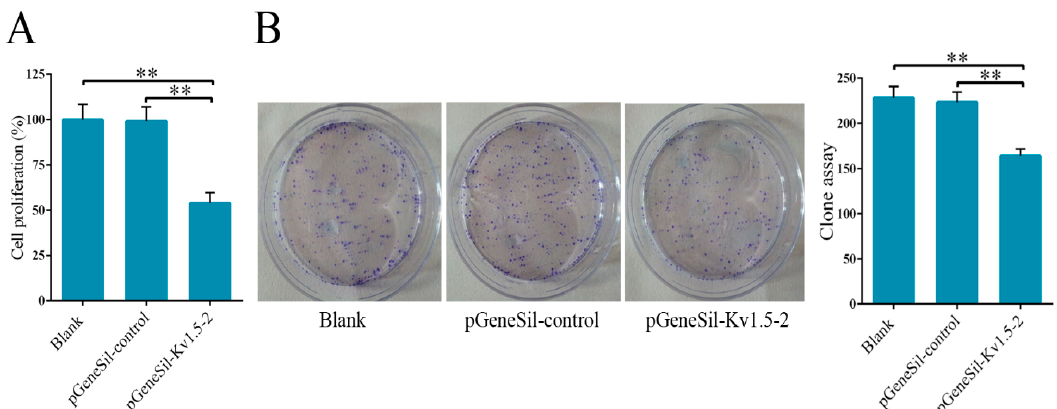
Figure 3. Knockdown of Kv1.5 reduces proliferation and growth of osteosarcoma cells. ( A ) The proliferation of MG-63 cells was determined by CCK-8 assay after transfection with Kv1.5-shRNA ( n = 6); ( B ) The growth of MG-63 cells was determined by colony formation assay ( n = 3). ** p < 0.01.